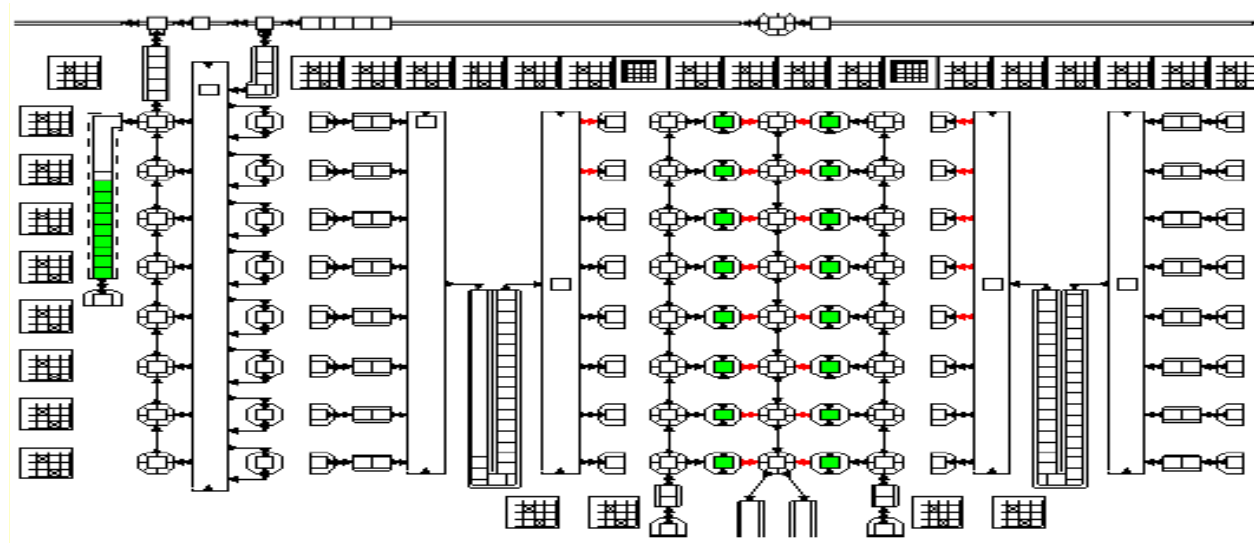
Figure 11. Animation-validation of flat billets flow in a walking beam furnace. Source: own study.